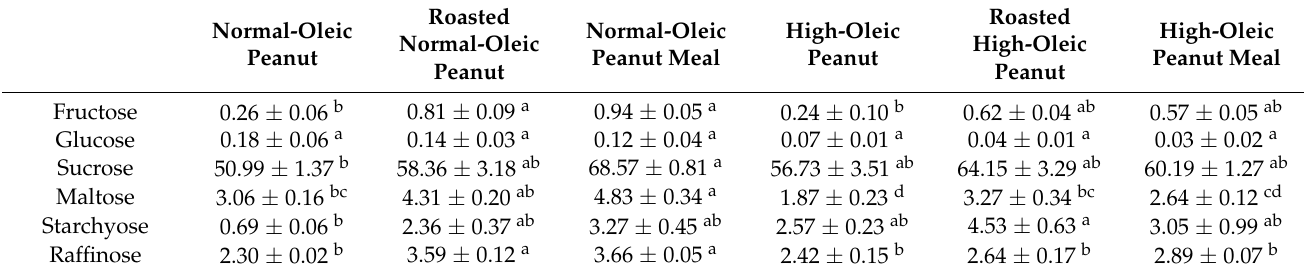
Roasted High-Oleic High-Oleic High-Oleic Peanut Peanut Peanut